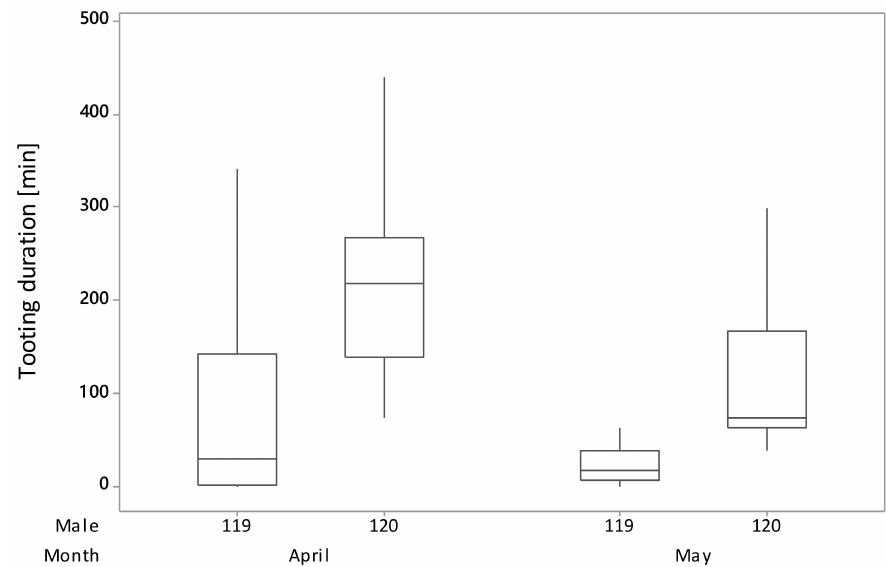
Figure 2. Month-dependent changes of tooting duration in Capercaillie male 119 and 120.